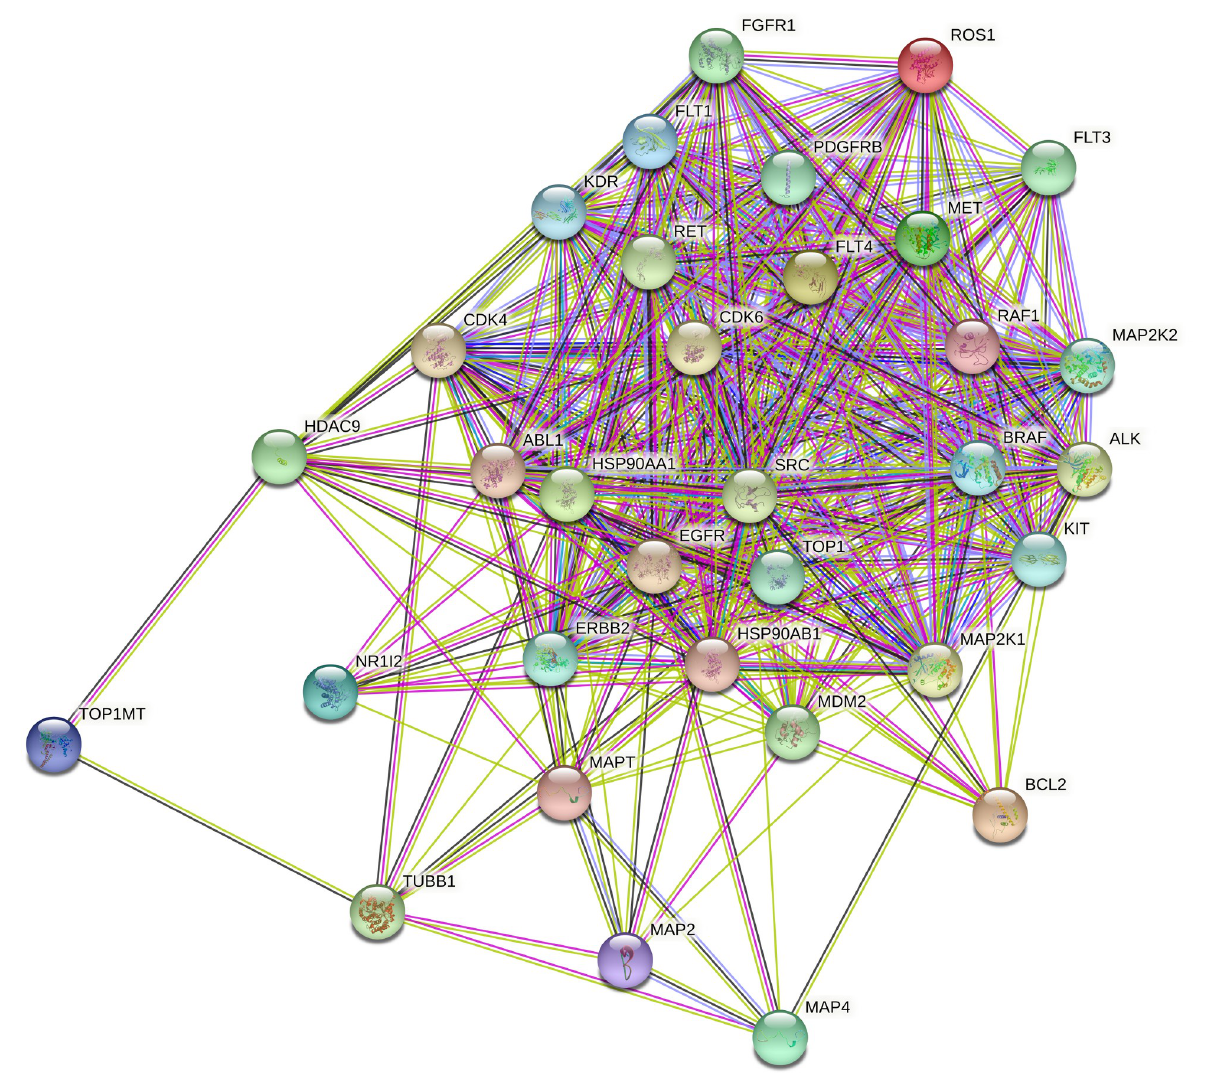
Fig 2. STRING network for drugs in CCLE.